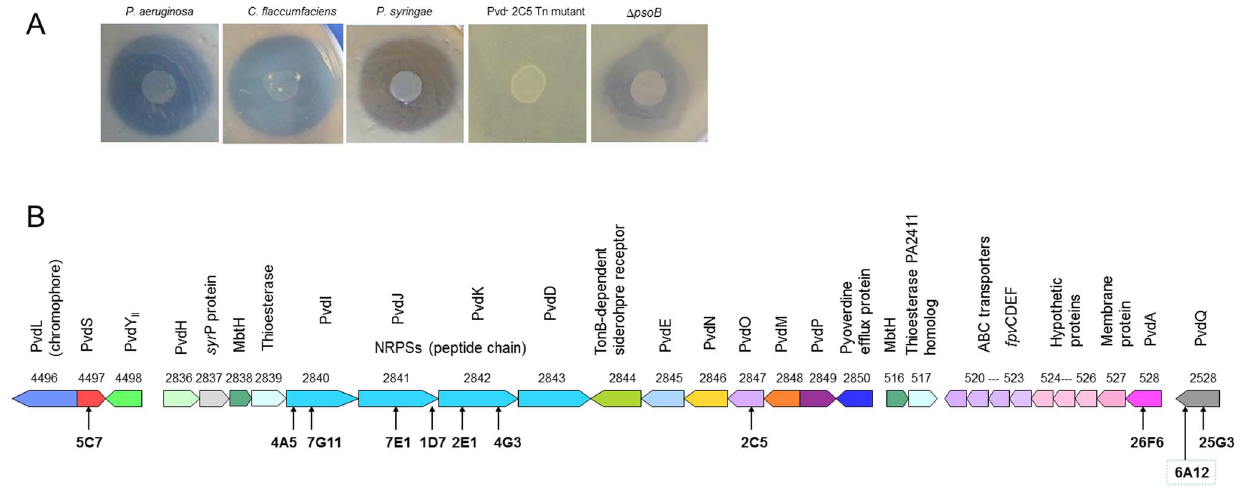
Figure 4. Antagonistic activity and role of pyoverdine in the antagonism. A. Antagonistic activity of the P. putida W15Oct28 strain against Pseudomonas aeruginosa , Curtobacterium flaccumfaciens , and Pseudomonas syringae . The pyoverdine-negative pvdO 2C5 transposon mutant has lost its antagonism against P. aeruginosa while the D psoB putisolvin-negative mutant keeps a reduced, but still visible level of antagonism. B. The pyoverdine genes clusters: the arrows indicate the places of transposon insertions causing the loss of pyoverdine production and of the antagonism.